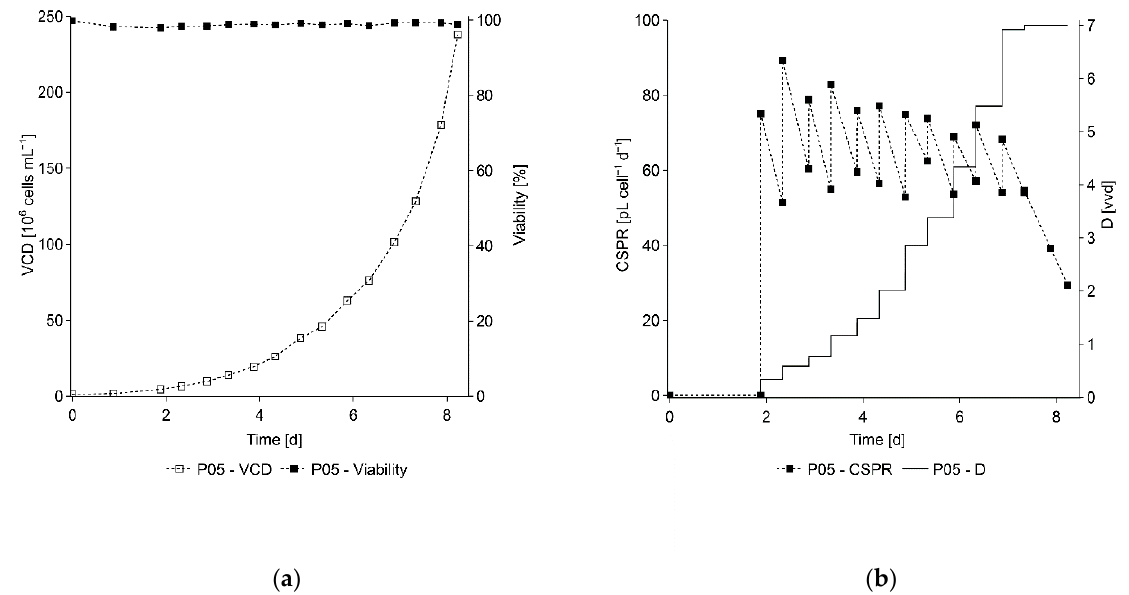
Figure 8. ( a ) Course of the VCD and viability of P05, and ( b ) course of D and the CSPR of P05, inoculated directly from the